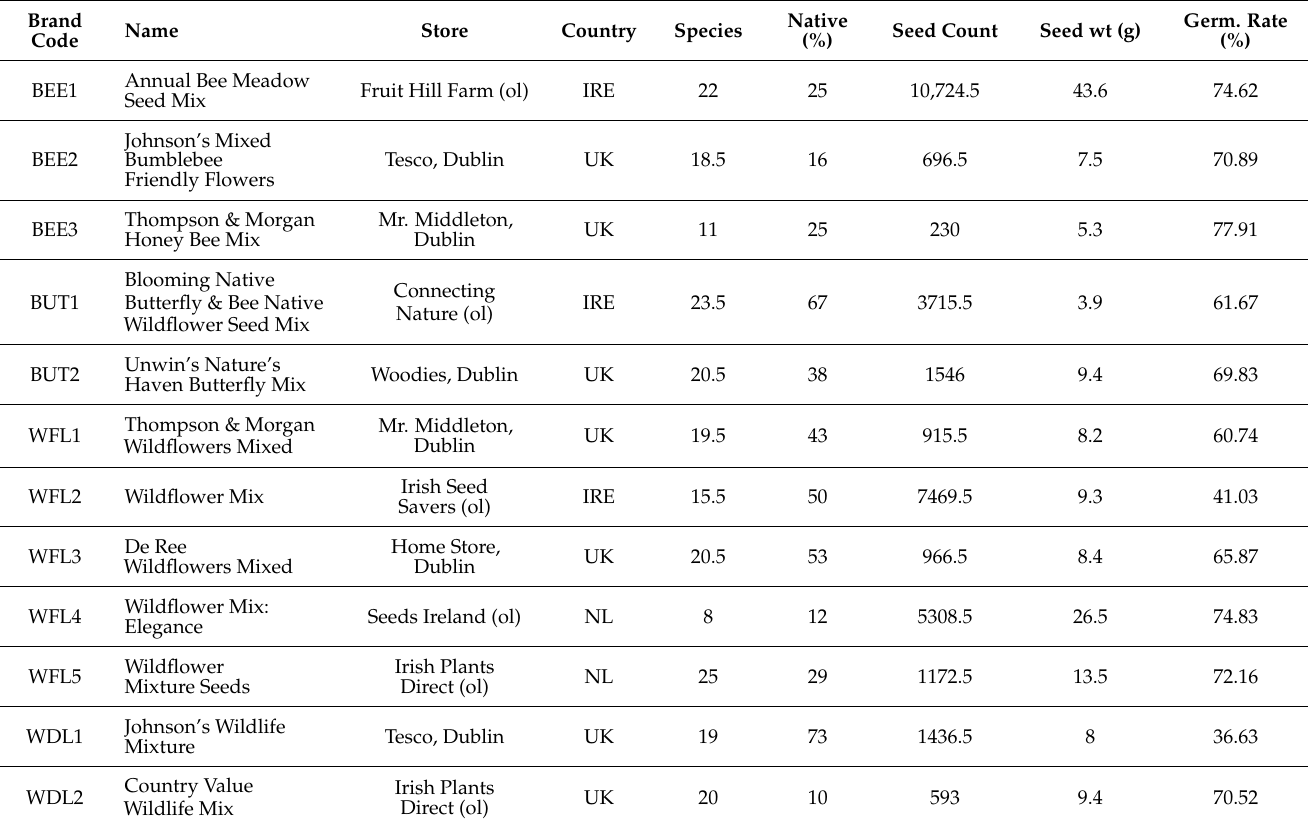
Table 1. Summary of twelve wildflower seed mixes purchased in Ireland in 2022. Name of seed brand, where purchased (ol—online purchase), country where produced, mean number of species per packet, mean number of seeds per packet, mean weight of seed per packet ( n = 2 packets per brand). The percentage of species native to Ireland was calculated using the total species in both packets, and only considered those seeds that could be identified to species